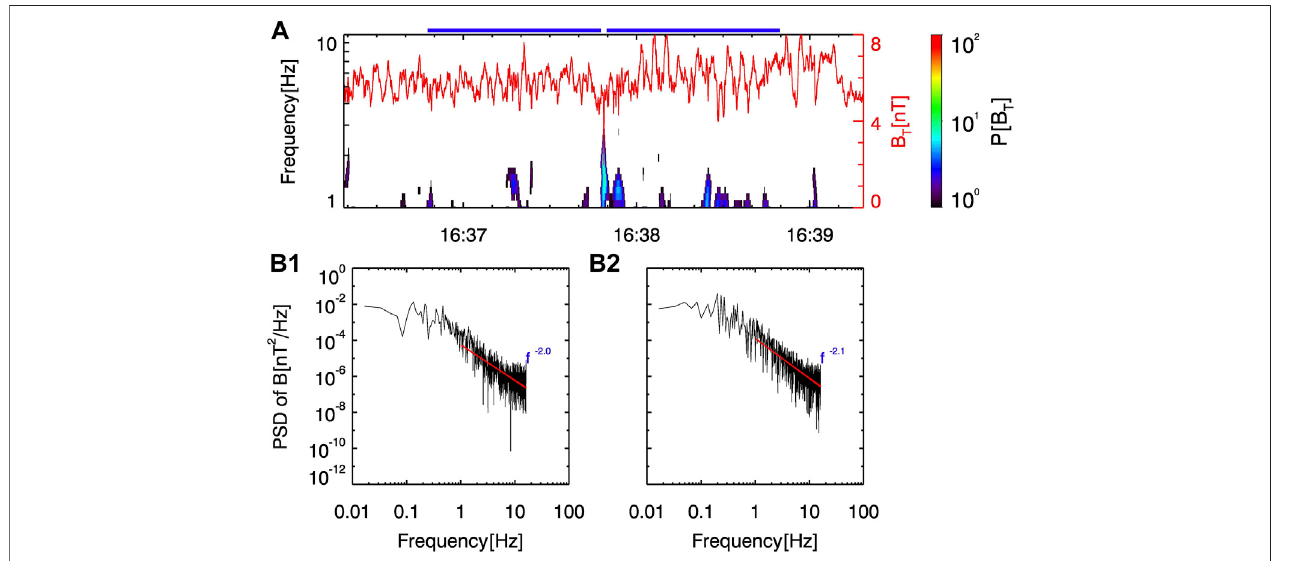
FIGURE 2 | (A) Wavelet spectrograph of the magnetic fi eld data, and the red curve is the time series of the magnetic fi eld magnitude; (B1) the PSDs computed by the 1-min window marked by the left blue bar in (A); (B2) the PSDs computed by the 1-min window marked by the right blue line in (A).